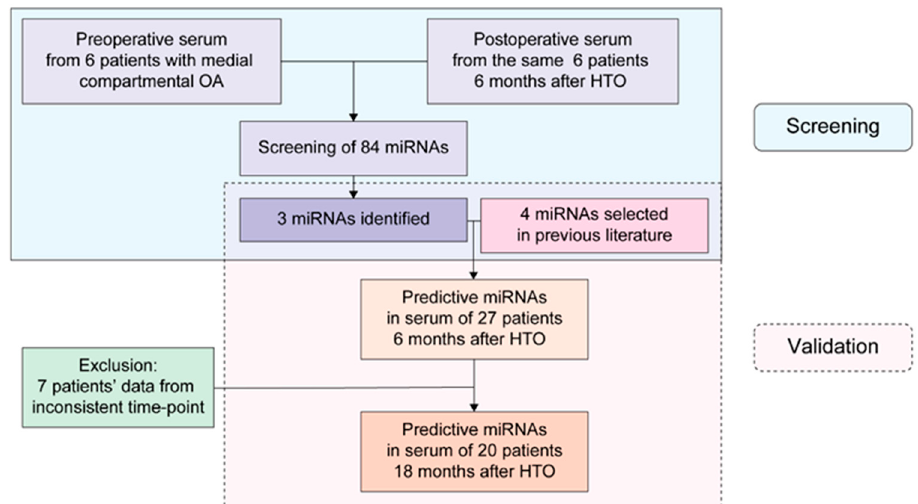
Figure 1. Study design. Three candidate miRNAs were identified in the serum from six patients with high tibial osteotomy at preoperative and postoperative time points. We evaluated their expression together with other four previously identified miRNAs (total seven miRNAs) in 27 patients at postoperative 6 months and 20 patients at postoperative 18 months for validation. Data of seven patients were excluded, owing to different collection time points.